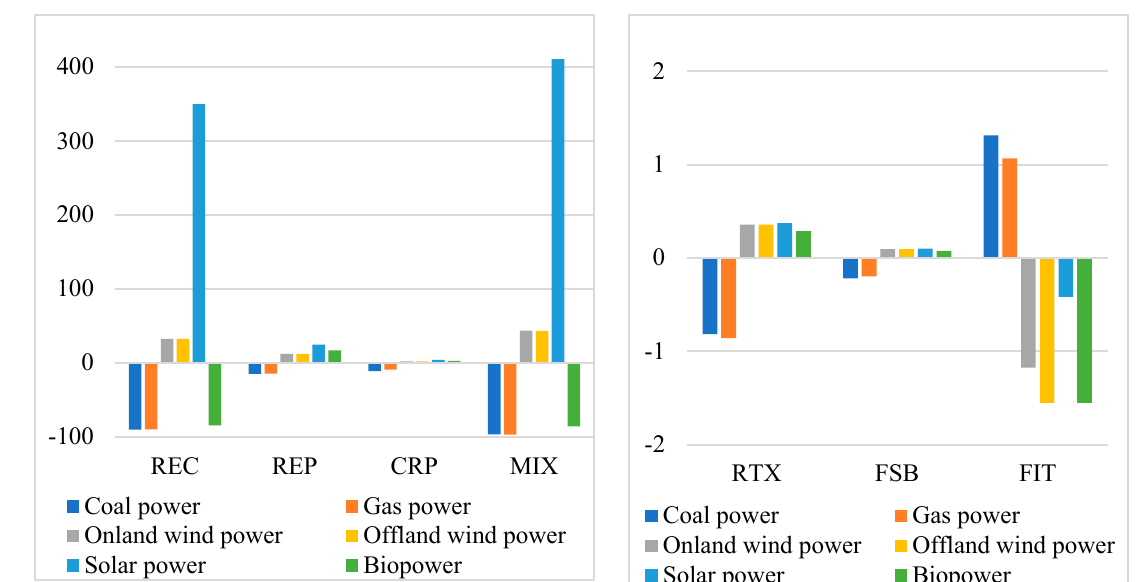
Figure 8. The accumulative changes in the output of electricity in 2020–2060, relative to the baseline scenario (%). Source: CHINAGEM model simulation.